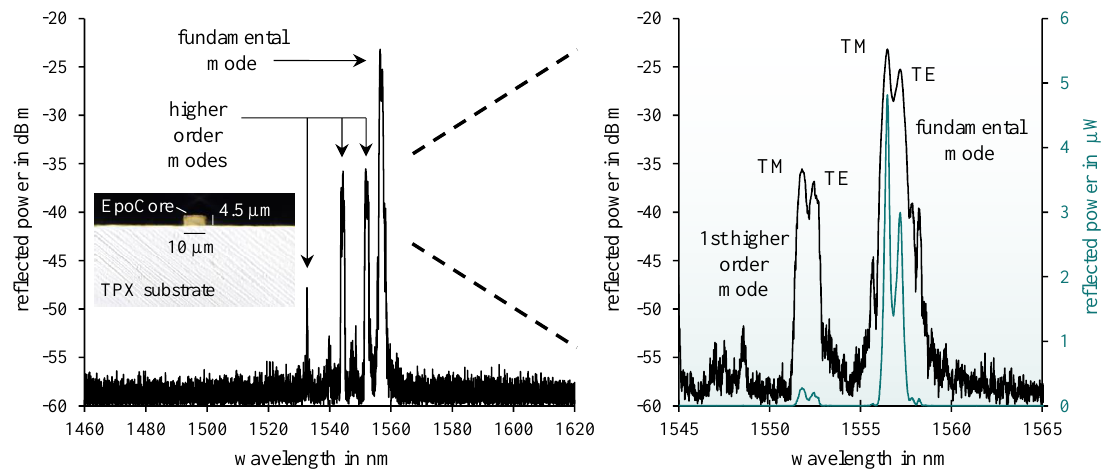
Figure 2. Typical reflection spectrum of an epoxy-based optomechanical Bragg grating sensor device. Multimode reflection peaks as well as distinctive peak splitting in TE and TM modal reflections can clearly be observed. The micrograph shows a cross sectional view of the waveguide Bragg grating.